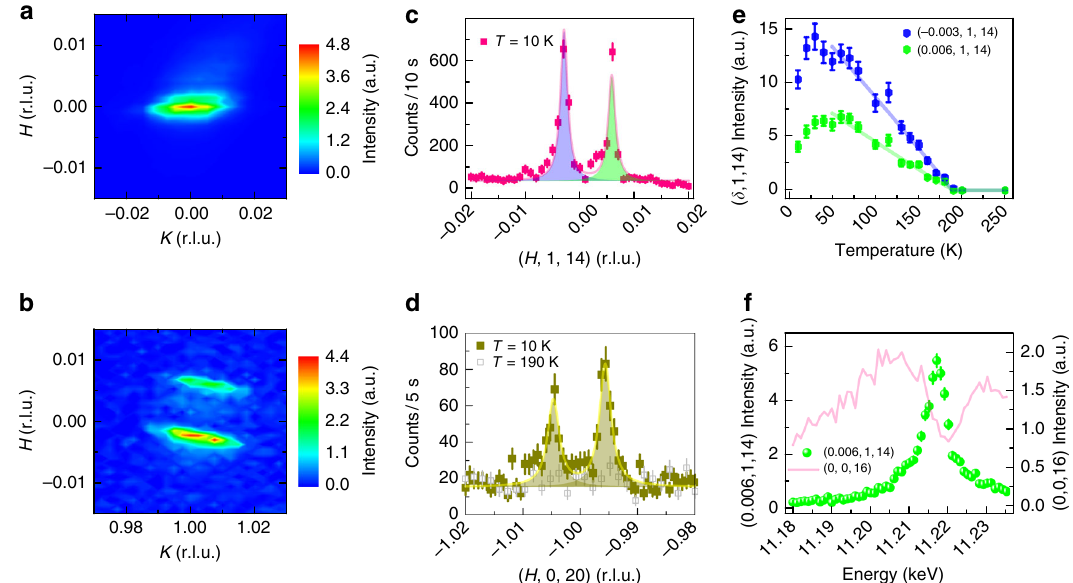
Fig. 4 REXS data from sample x = 0.041 taken at CHESS, A2. a and b show H,K maps T = 10 K around the nuclear (0, 0, 16) and magnetic (0, 1, 14) zones respectively. c H scan at (0, 1, 14) at 10 K exhibiting two IC peaks at ( − 0.003, 1, 14) and (0.006, 1, 14). d H scan at ( − 1, 0, 20) showing the two IC peaks split along the H direction 10 K and their absence at 190 K. IC peaks in c and d are both separated by 0.009 r.l.u. e The temperature dependence of the two IC peaks. Both IC peaks disappear at the same temperature T SDW = 182 ± 8 K. f Energy dependence of the IC peak at (0.006, 1, 14) and its comparison to the (0, 0, 16) charge peak. The solid lines in c – e are the fi ts to the data. Other than f , all data are collected at the energy of 11.217 keV. All vertical error bars in the fi gure represent 1 s.d. statistical